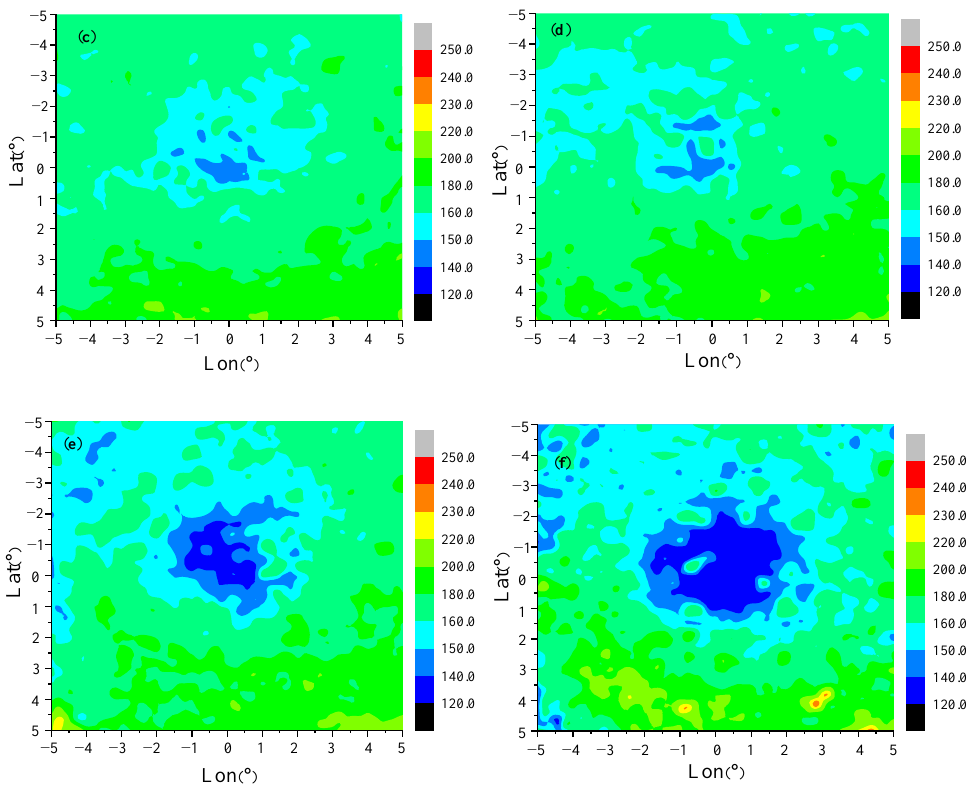
Figure 7. Spatial distribution of ice cloud top pressure by different TC intensity: ( a ) TD, ( b ) TS, ( c ) STS, ( d ) TY, ( e ) STY, and ( f ) Super TY.